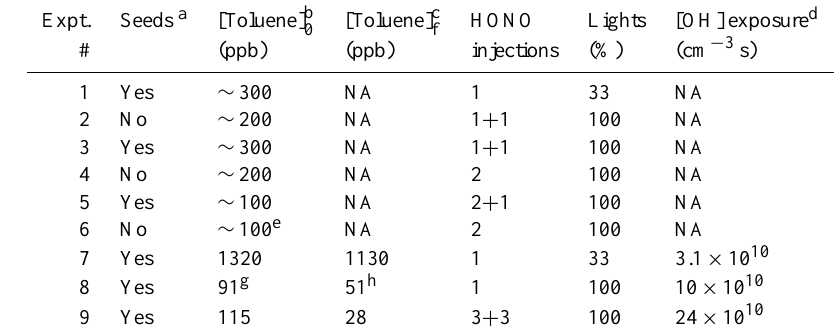
Table 1. Experimental conditions.